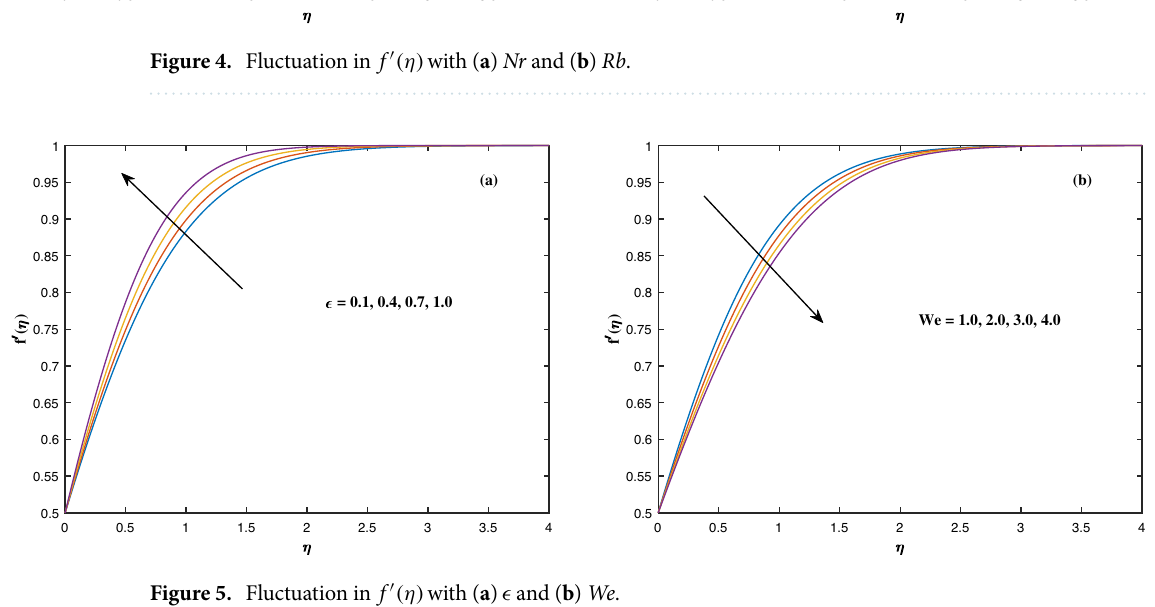
Figure 5. Fluctuation in f ′ (η) with ( a ) ǫ and ( b ) We